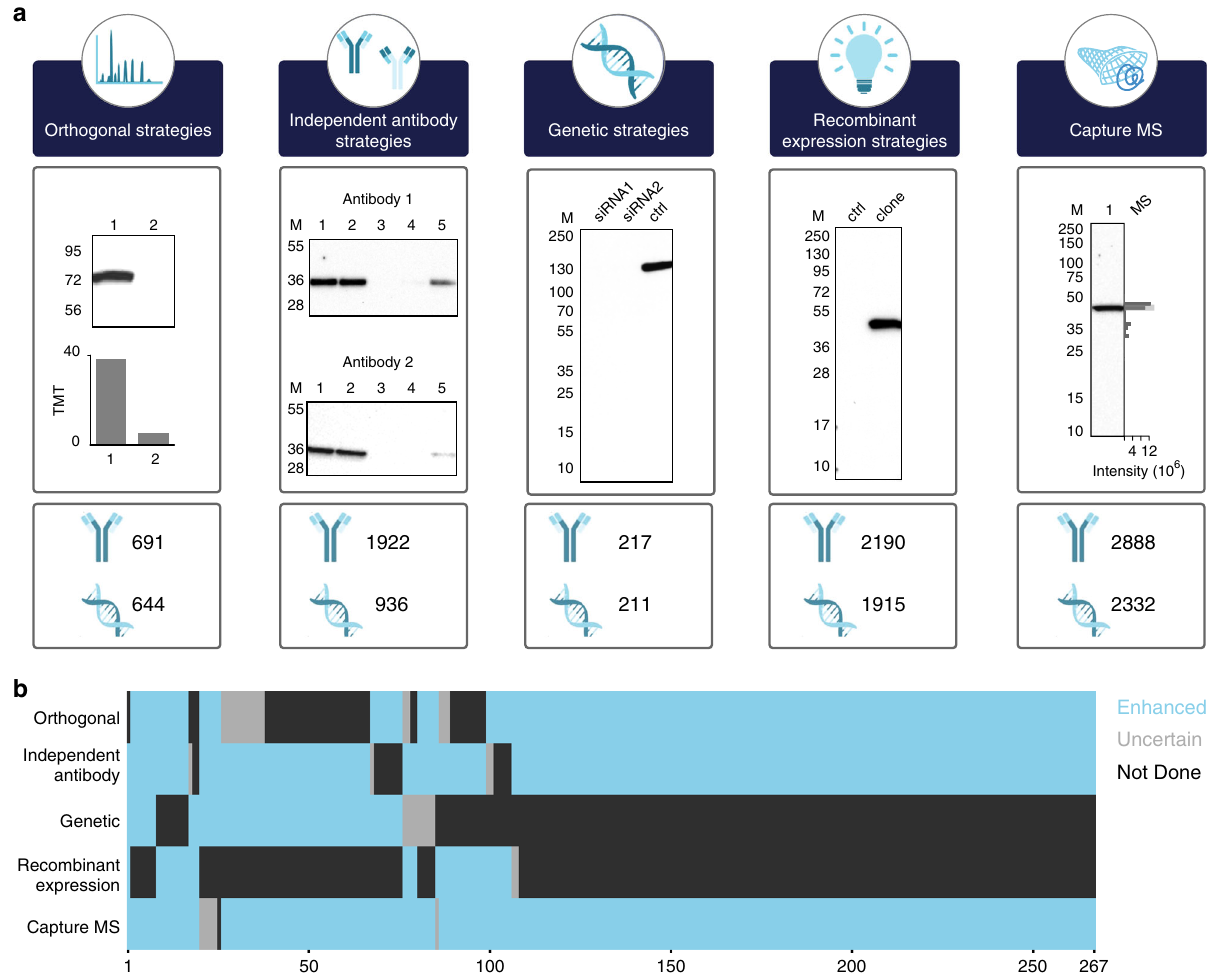
Fig. 4 Summary of the fi ve-pillar strategy used for antibody validation. a Summary of the fi ve-pillar strategy employed within the Human Protein Atlas with the number of enhanced validated antibodies together with gene-coverage in each respective category. b Heat map showing 267 antibodies with enhanced validation (blue) in more than three of the fi ve pillars. The two other validation states include not done (black) and uncertain